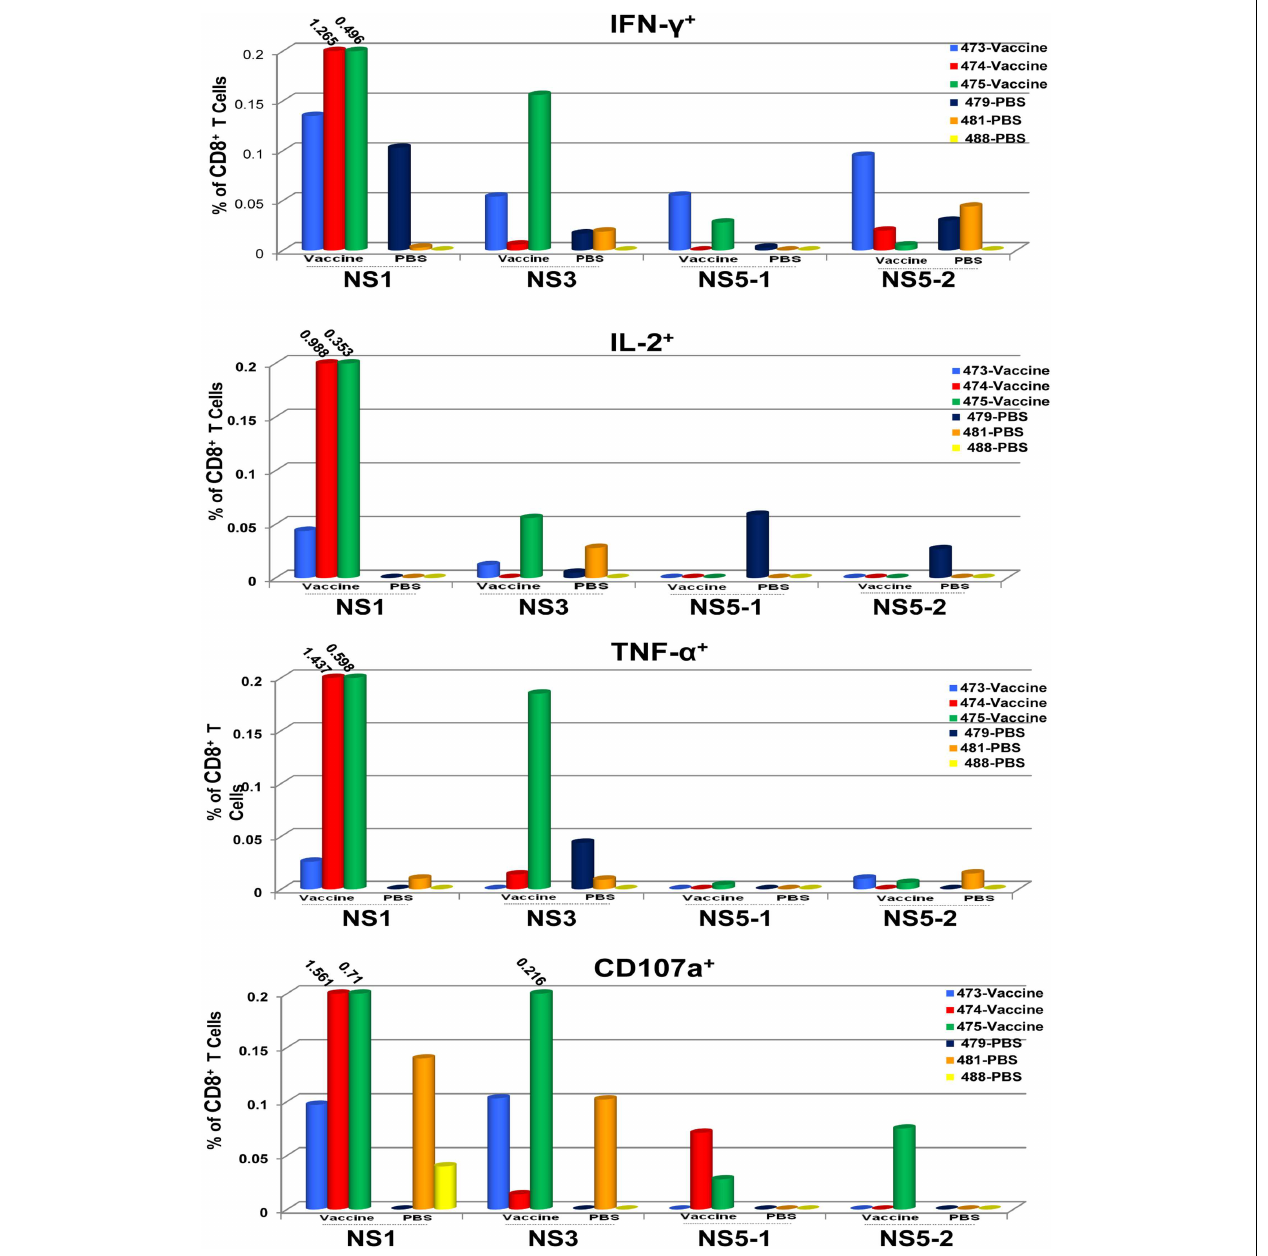
percentage of cytokine-positiveT cells in medium only treated cells subtracted. Peptide arrays for NS5 were split into two pools; NS5-1 and NS5-2. PBMCs from PBS immunized animals were used as